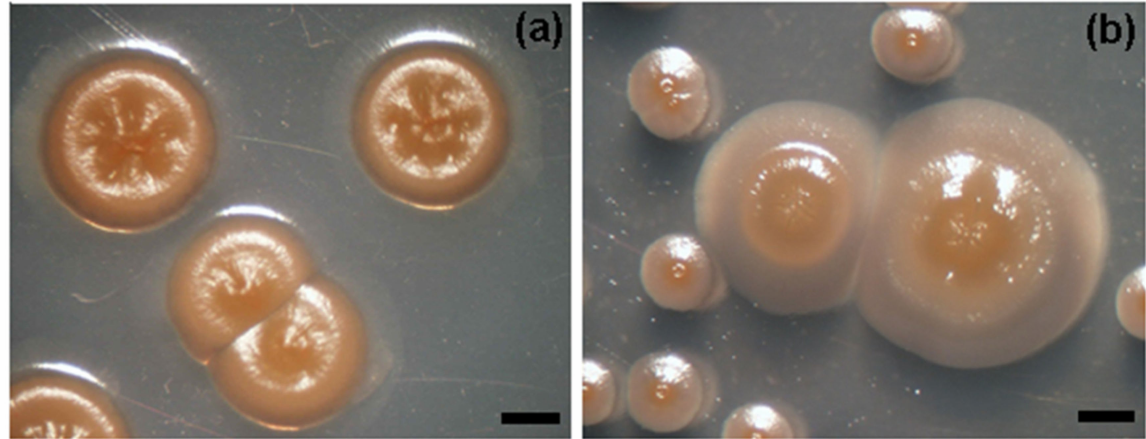
Figure 1. ( a ) Typical morphology of N. gerenzanensis colonies growing on Medium V0.1 agar without antibiotic addition: colonies appeared uniform in color, size, and shape. ( b ) Colonies growing in the presence of 2 µ g/mL of A40926 showed a different morphology and dimensions: on the basis of their diameter, it was possible to distinguish P (petit, small) from G (grand, big) colonies. Bars are 0.8